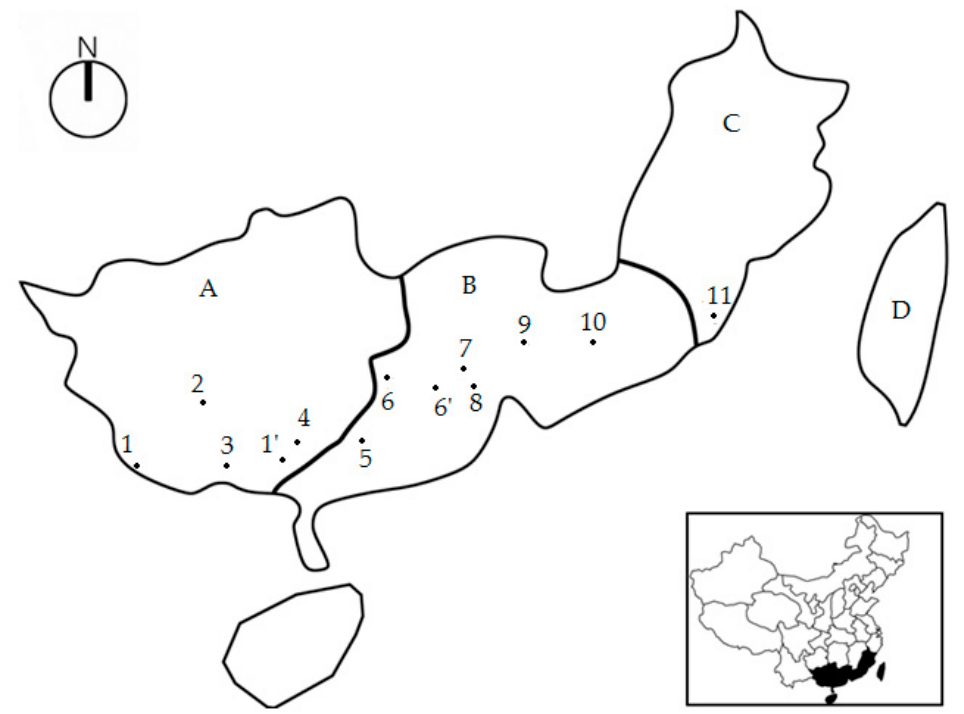
Figure 1. Localities of 11 populations of Erythrophleum fordii Oliv. in China. Notes: A, Guangxi Zhuang Autonomous Region; B, Guangdong Province; C, Fujian Province; D, Taiwan Province. Numbers in Figure 1 were represented the codes of population. P1 introduced from P1’ (Hepu, Guangxi); P6 introduced from P6’ (Dinghushan National Natural Reserve at Zhaoqing, Guangdong).